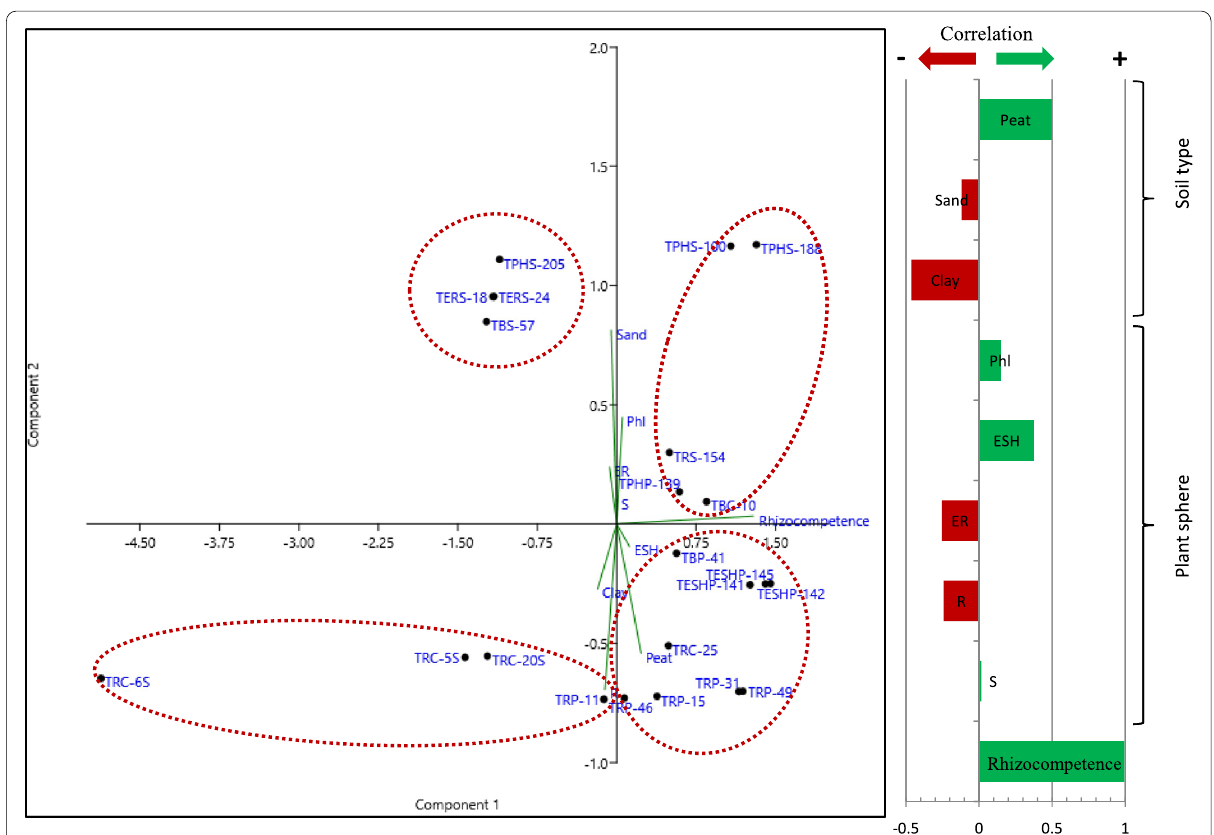
Fig. 5 PCA analysis showing the correlation between rhizocompetence potential and the origin of bacterial